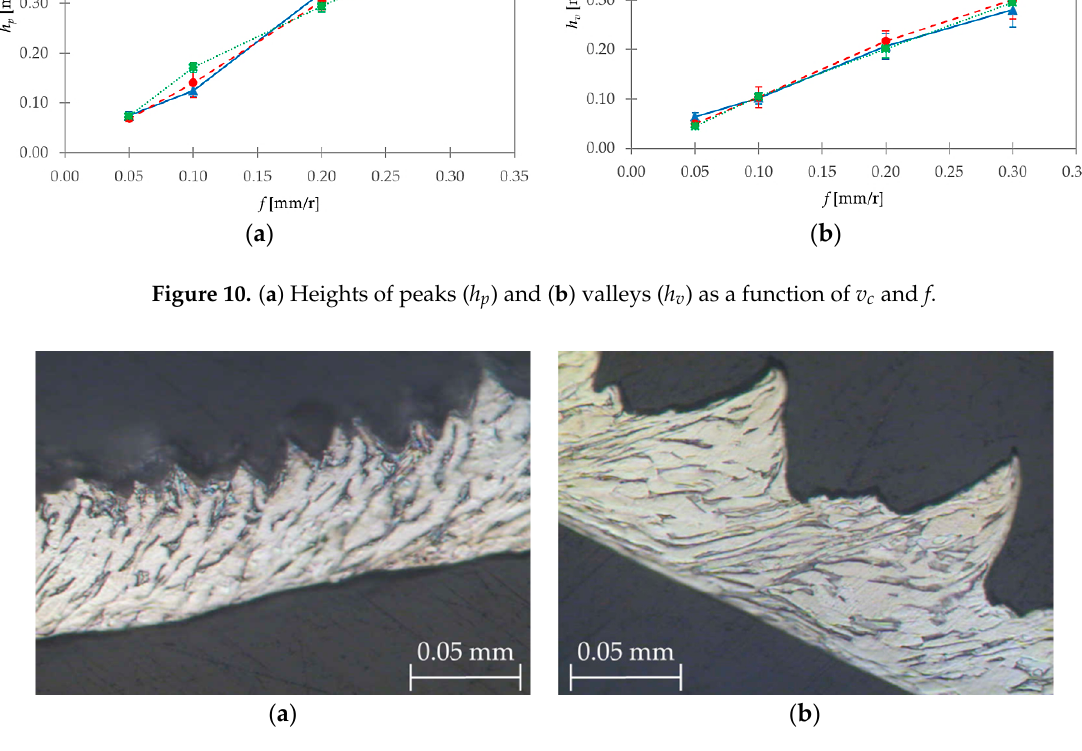
Figure 11. Chip SOM images (100×) for f = 0.05 mm/r: ( a ) v c = 30 m/min, and ( b ) v c = 125 m/min. These observations were complemented by the calculations of the segment ratio ( G s , Equation (3)) and the equivalent chip thickness ( t c , Equation (4)). Their evolutions with v c and f are shown in Figure 12.